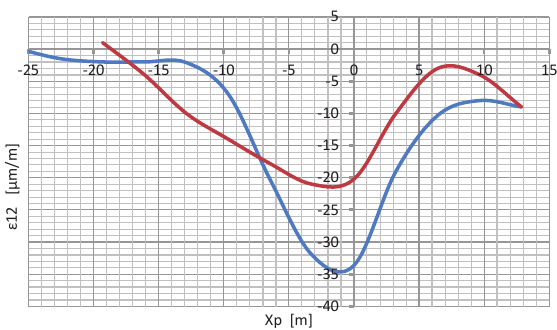
Figure 5: Functions ε